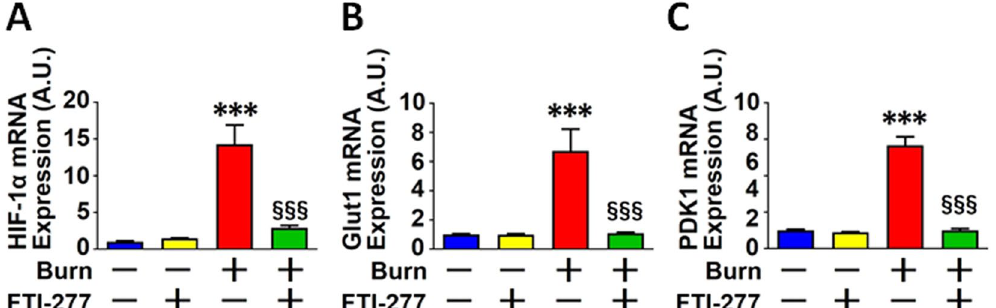
Figure 3. FTI-277 treatment reversed burn-induced induction of HIF-1 α , Glut1, and PDK1 genes expression in skeletal muscle. mRNA levels of HIF-1 α , Glut1, and PDK1 in skeletal muscle were significantly increased at 3 days after burn. FTI-277 treatment prevented these alterations ( A – C ). *** P < 0.001 vs. sham-burn groups, §§§ P < 0.001 vs. vehicle-treated burn group. n = 6 mice per